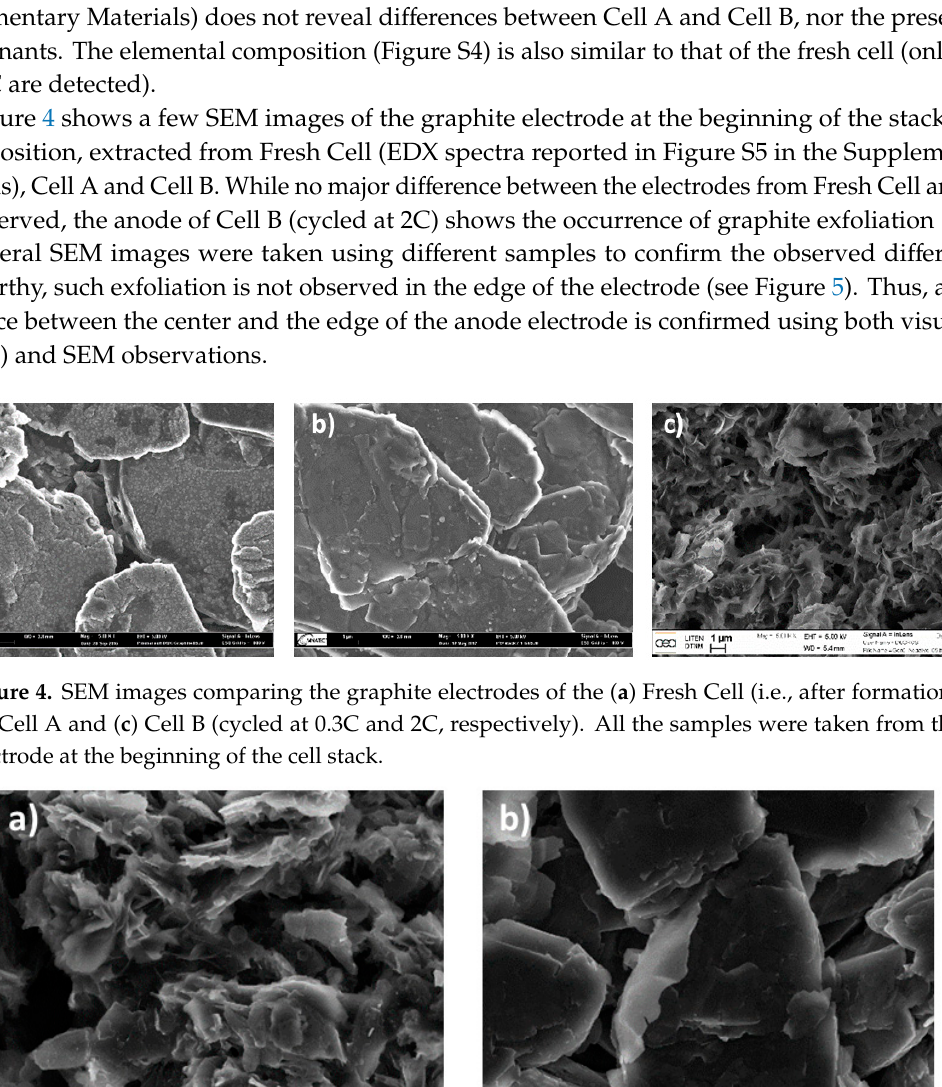
Table 4. Description of sample positioning in the stack and within the electrode, sample coding and residual capacity. Cell Position in the Stack- Electrode Number